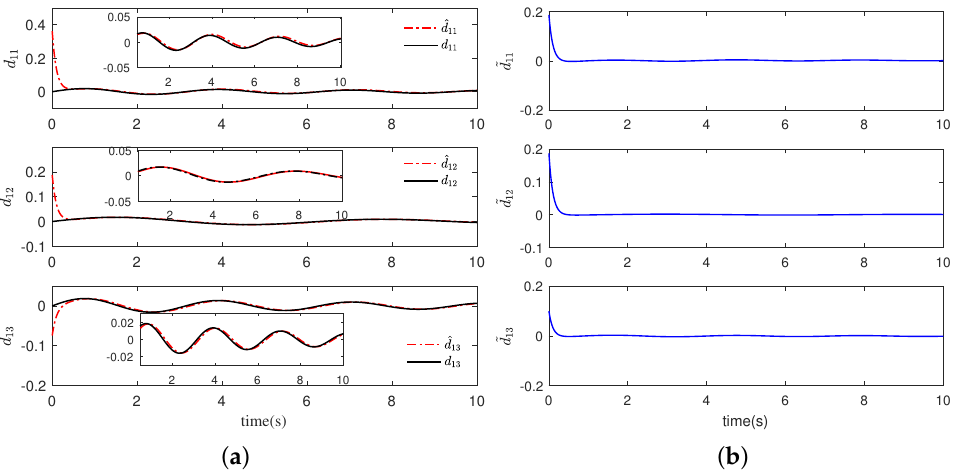
Figure 3. Slow-loop disturbance estimation response curve of the NDO: ( a ) d 1 and ˆ d 1 (rad/s); ( b ) the estimation error ˜ d 1